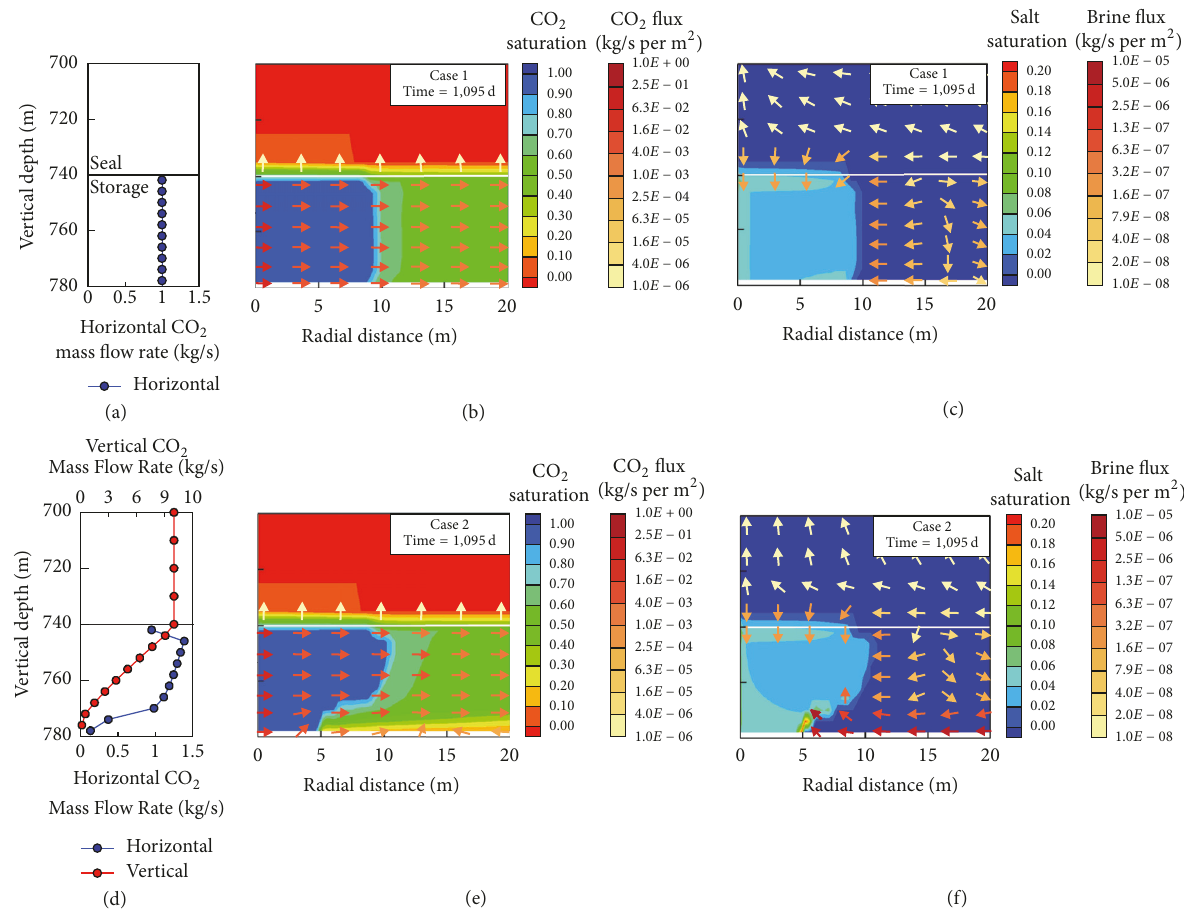
Figure 5: Flux patterns for CO 2 and brine near the injection well after the injection of 1,095 days. (a) and (d) predicted CO 2 mass flow rate [kg/s] within grid-blocks representing the wellbore; blue circles are horizontal CO 2 mass flow rate from the wellbore to the storage formation and red symbols are vertical CO 2 mass flow rate within the wellbore. (b) and (e) indicate CO 2 flux [kg/(s ⋅ m 2 ) ] with CO 2 saturation. (c) and (f) indicate brine flux [kg/(s ⋅ m 2 ) ] with salt saturation. The arrows indicate directions for both CO 2 and brine flux, and the colors represent their